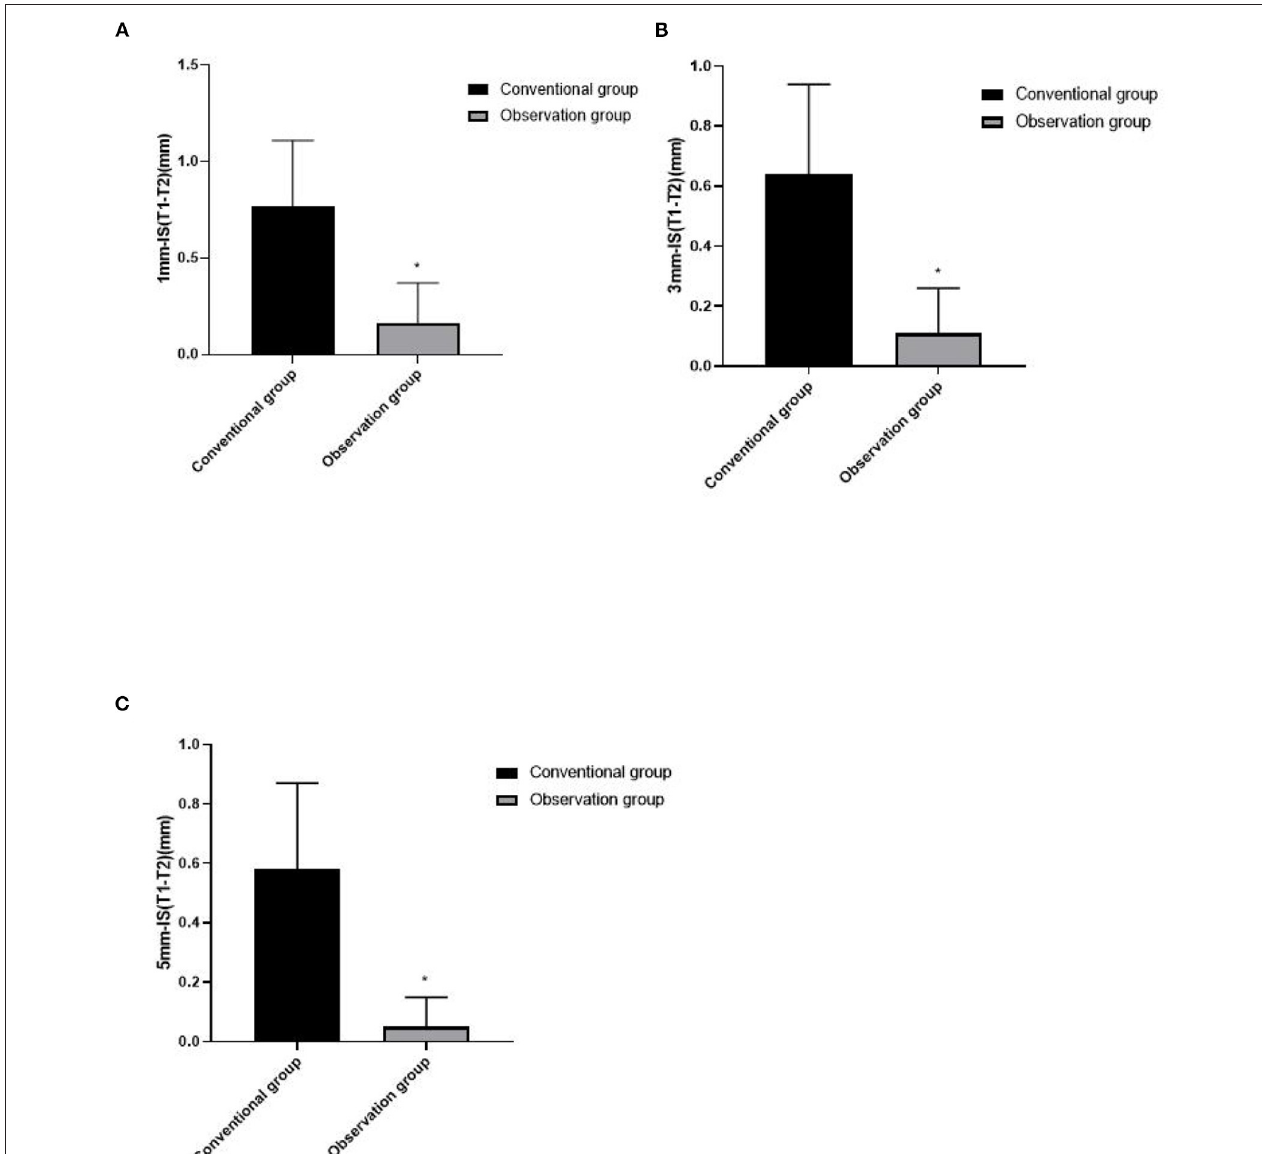
FIGURE 4 | Comparison of absorption of labial bone plate between two groups. (A) 1mm-IS(T1-T2), (B) 3mm-IS(T1-T2), and (C) 5mm-IS(T1-T2). Compared with the conventional group, * p <